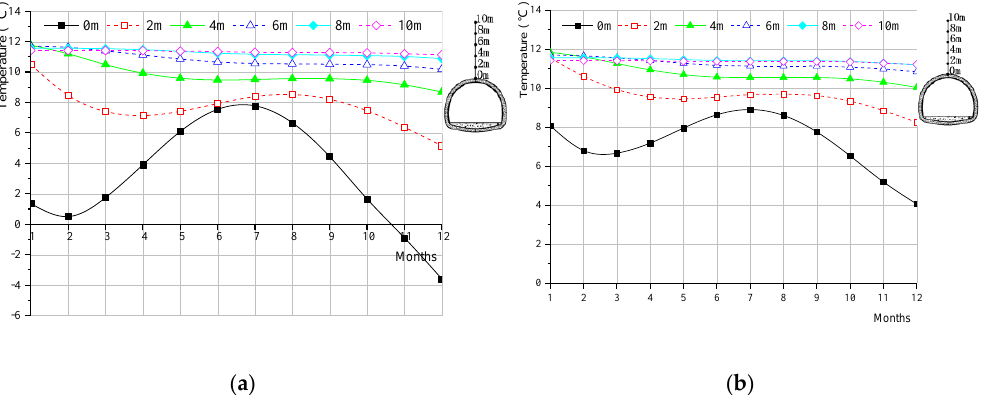
Figure 14. Monthly average temperature curves of surrounding rock at tunnel vault: ( a ) without heat-insulating layer and ( b ) with heat-insulating layer (K0 + 015 cross-section).